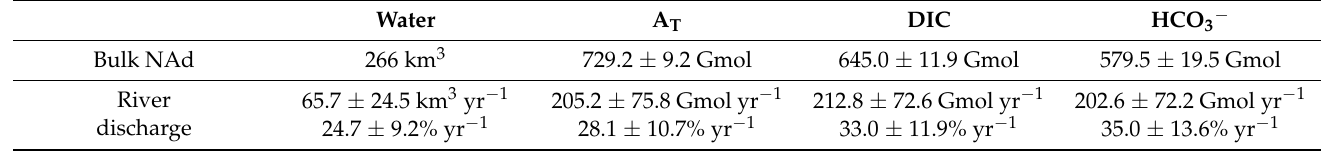
Table 2. Comparison between the volume of the North Adriatic (NAd) and the annual river discharge, as well as the budgets (Gmol) and mean annual river discharges (Gmol yr − 1 ) of the A T , DIC and HCO 3 − . Turnover rates of all the parameters are expressed as percentage per year (% yr − 1 ).